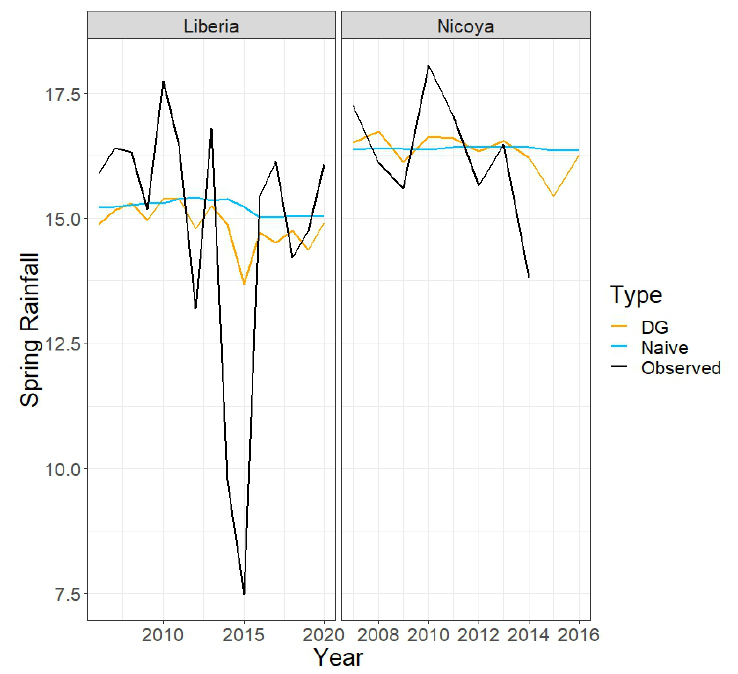
Figure 3. Predicted (using the double Gaussian and naive approaches) and observed total spring rainfall values at the Liberia station ( left ) from 2006 to 2020 and at the Nicoya station ( right ) from 2007 to 2016. Rainfall is reported on the scale log ( Y it ) + 1.